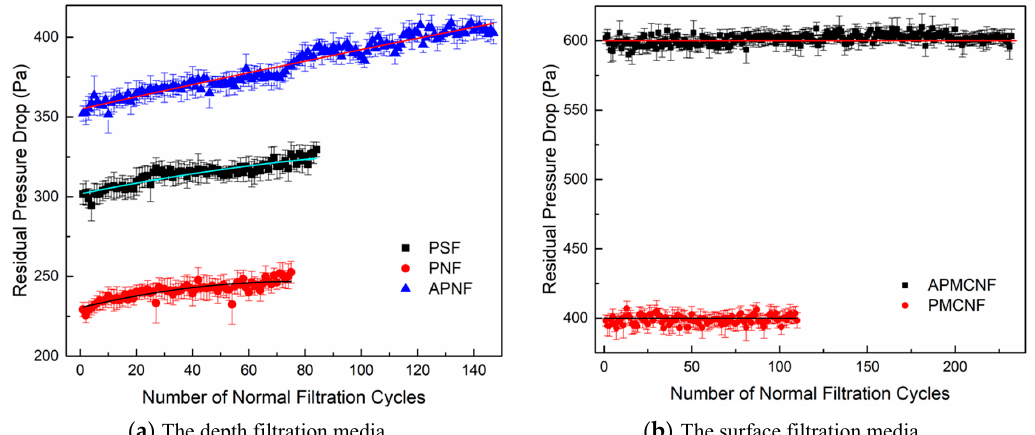
Figure 12. The changes in the average residual resistance drop of the five filter media during the performance test period.